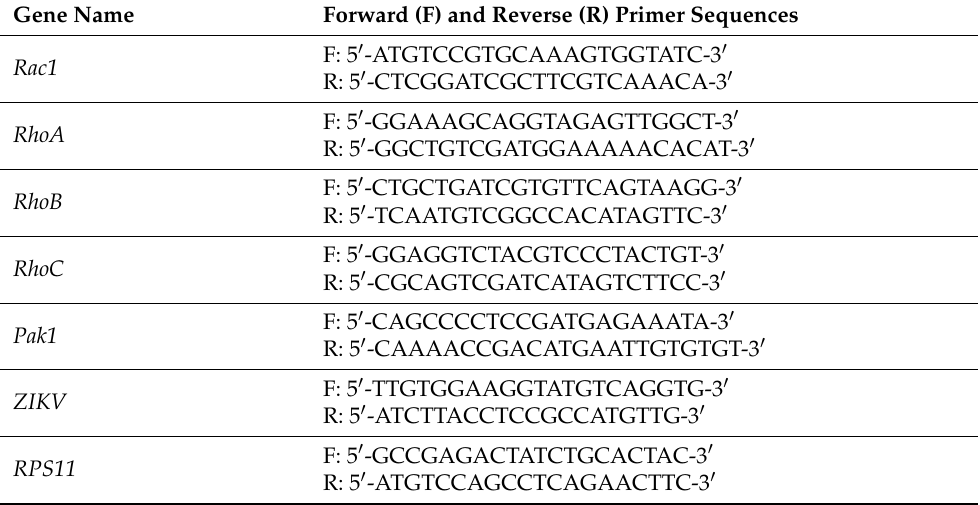
Table 1. Cont. Gene Name Forward (F) and Reverse (R) Primer